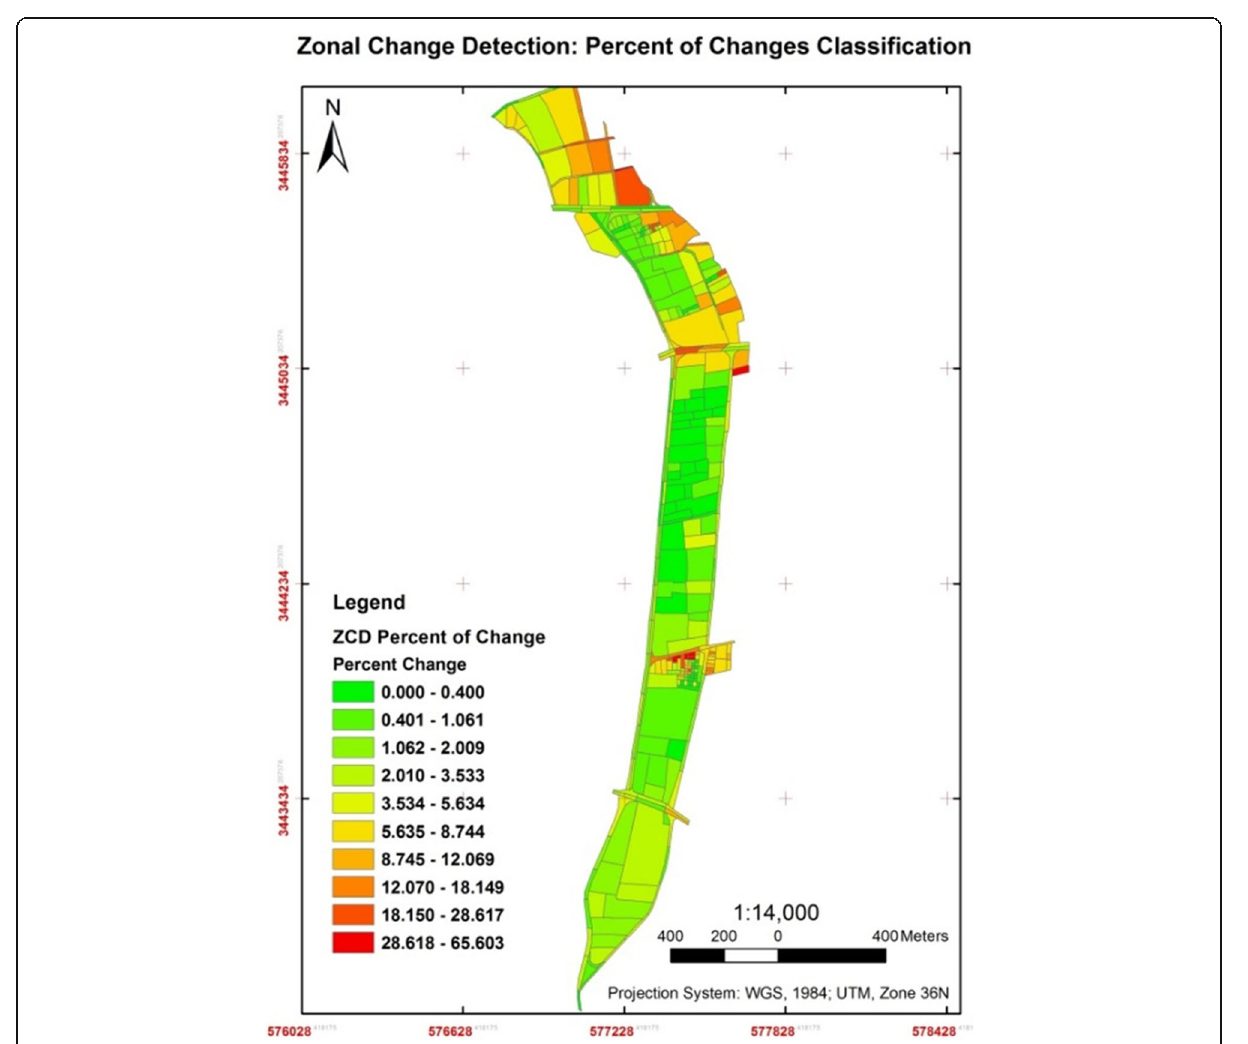
Fig. 4 The changes between the before and after images as a result from the zonal change detection